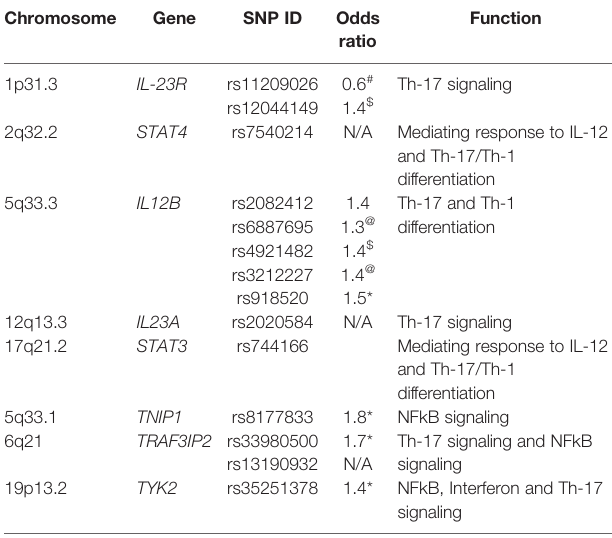
TABLE 1 | Genetic variants related to the IL-23/IL-17 axis found associated with PsA through GWAS or consistently identi fi ed in targeted analysis studies.